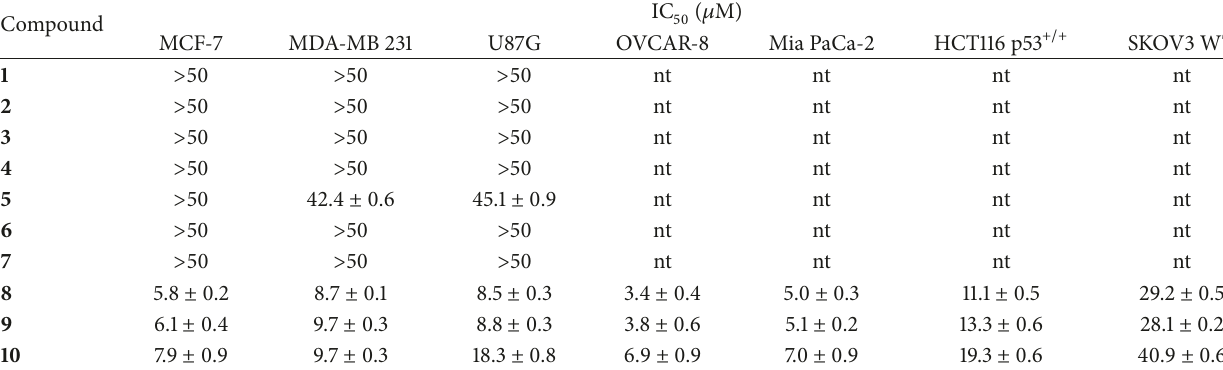
Table 2: Cytotoxicity of the synthesized compounds against a panel of human cancer cell